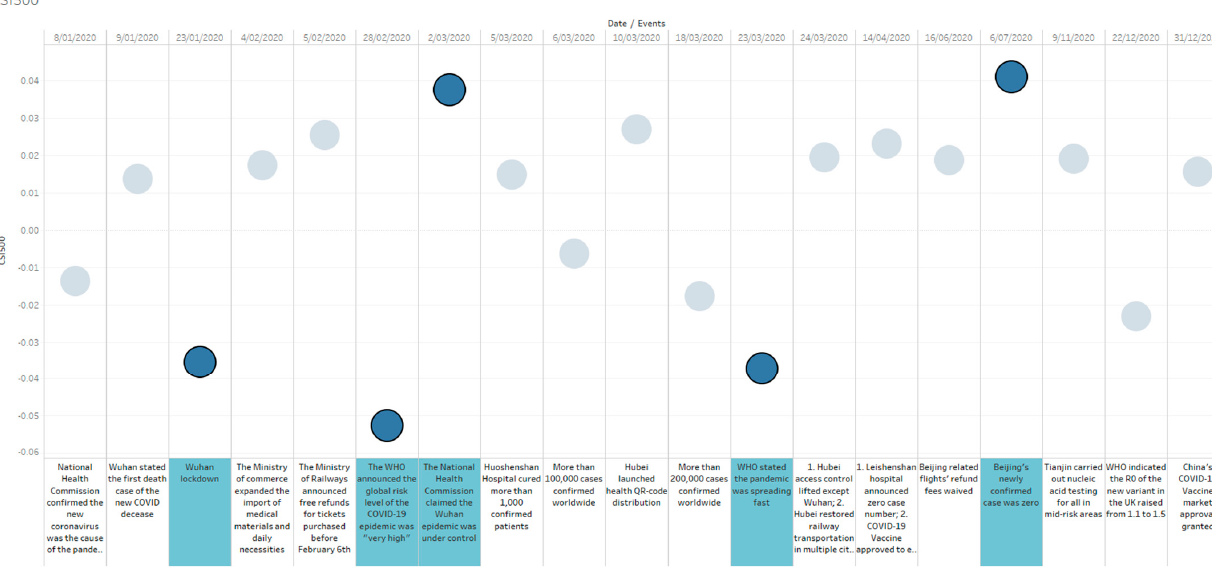
Figure 3. HSI’s trends on relevant social events.